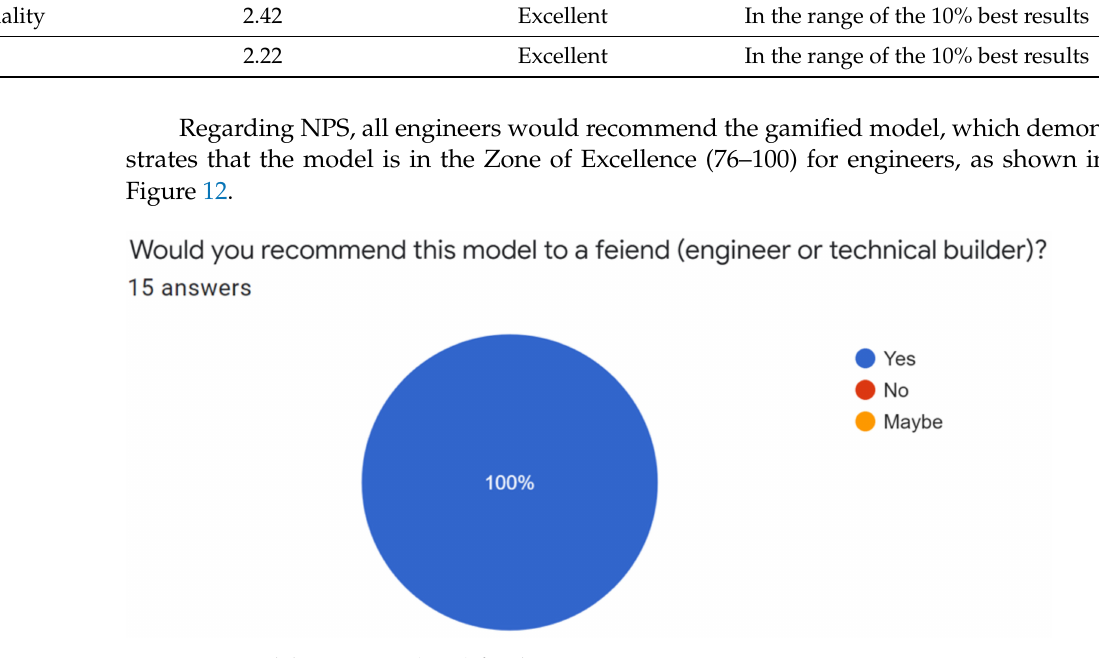
Figure 12. Model promotion (NPS) for the